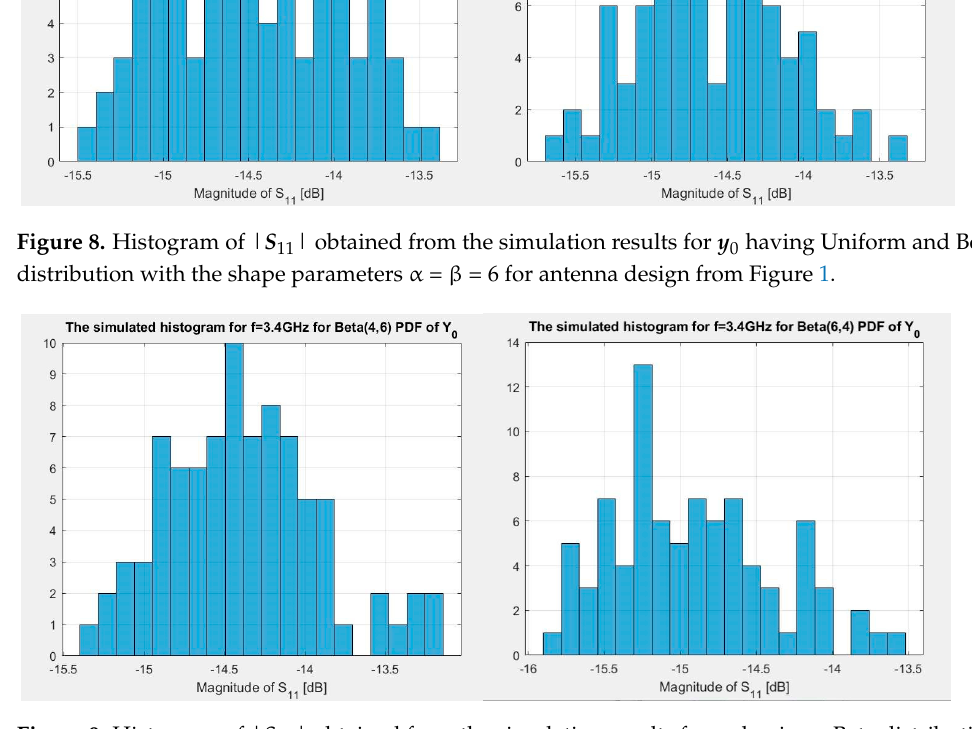
Figure 9. Histogram of | S 11 | obtained from the simulation results for y 0 having a Beta distribution with the shape parameters α = 4, β = 6 and α = 6, β = 4 for antenna design from Figure 1.